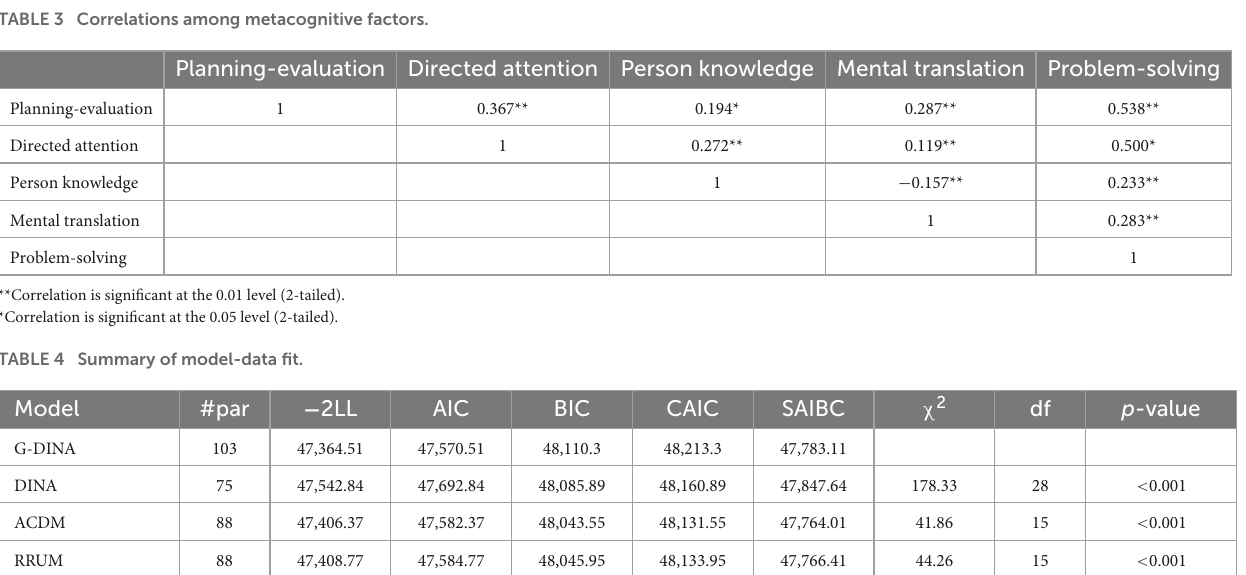
TABLE 3 Correlations among metacognitive factors.